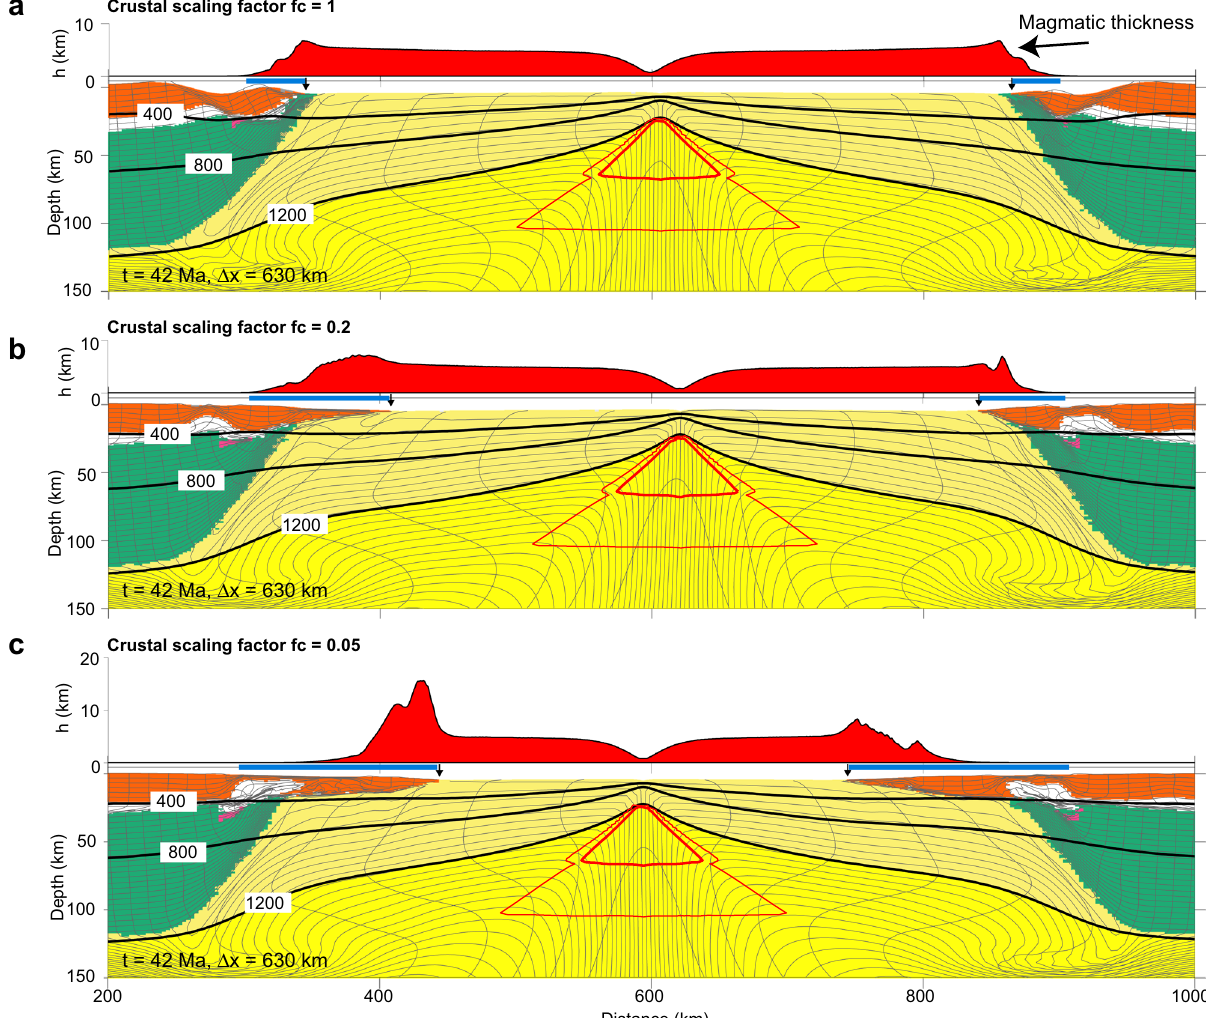
Fig. 3 Melt production for models with intermediate crustal strength between end-member models I and II. a – c Snapshots of models with decreasing crustal strength as represented by the Wet Quartz rheology 34 with viscosity-scaling factors ( f c ) from 1 to 0.05, leading to increasing margin width and melt thickness at the distal margin. All models shown are at the same time and amount of extension as the fi nal stage of Model II in Fig. 2. Black arrows indicate COB. Blue bars indicate margin